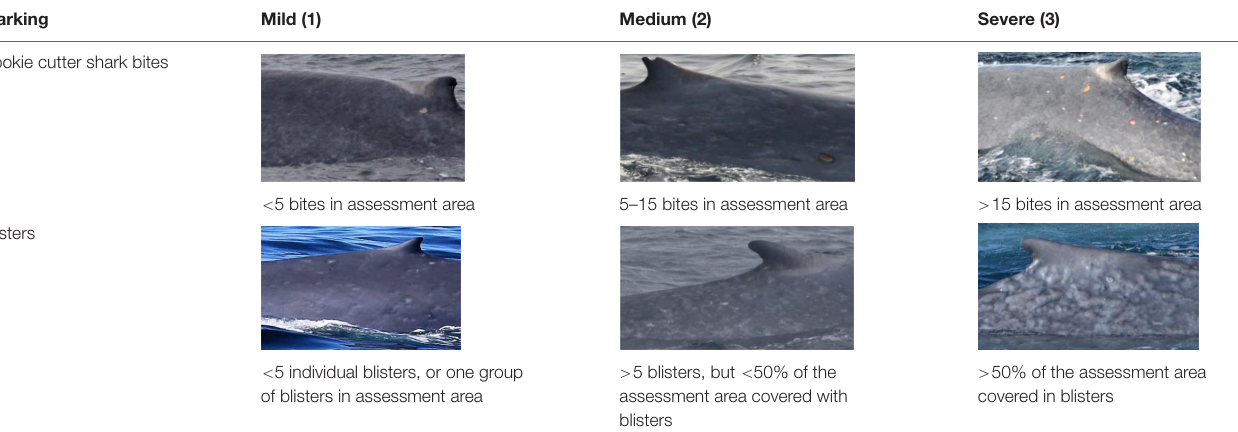
TABLE 2 | Definitions and reference images for each severity category for cookie cutter shark bite and blister lesions.